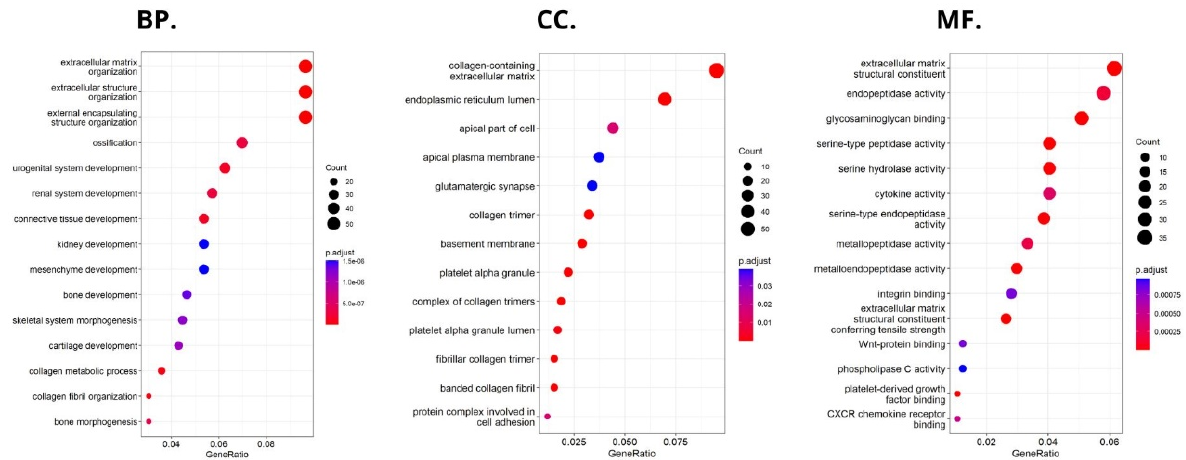
Figure 14. Significantly enriched GO annotations of HHLA2 in FieldEffectCrc dataset: (BP) biological processes; (CC) cellular components; (MF) molecular functions.